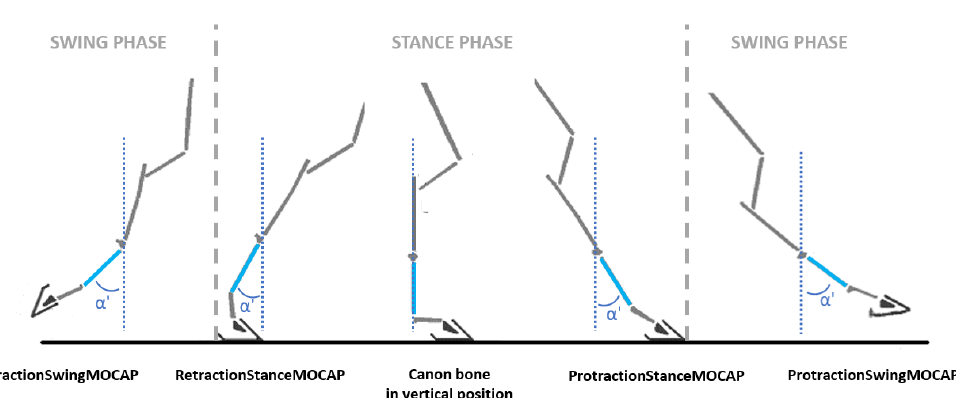
Figure 3. Graphic representation of the moments of the stride at which the angular values α ’ of protraction and retraction were measured. (Adapted from the illustration by [42]).